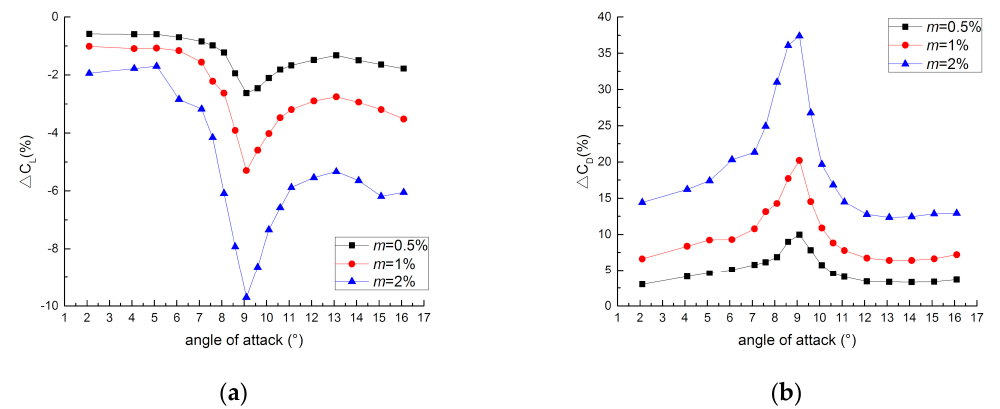
Figure 9. Particle concentration effects on lift and drag coefficient increments of S809 airfoil at Re = 1 × 10 6 : ( a ) Lift coefficient increment; ( b ) drag coefficient increment.